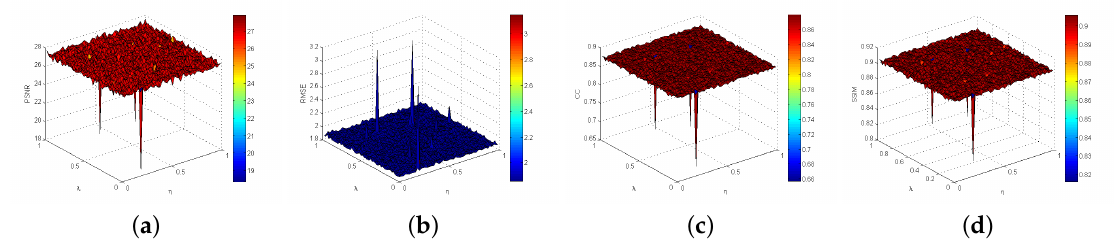
Figure 7. Results of the proposed method with different values of parameters λ and η tested in Bands 4/3 of MODIS. ( a ) PSNR versus λ and η ; ( b ) RMSE versus λ and η ; ( c ) CC versus λ and η ; ( d ) SSIM versus λ and η . Table 5. PSNR (dB) with different parameters in different images. λ